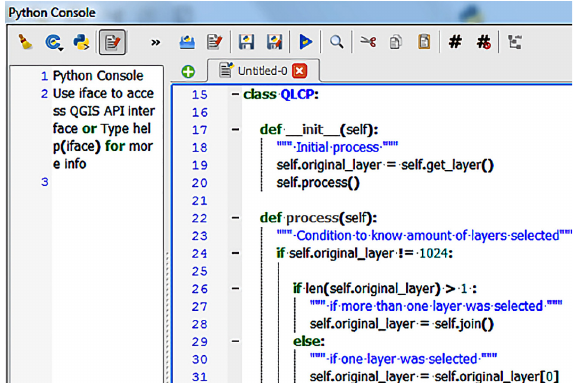
Fig. 9. Geospatial metadata cleaning using GeoWebCln tool.